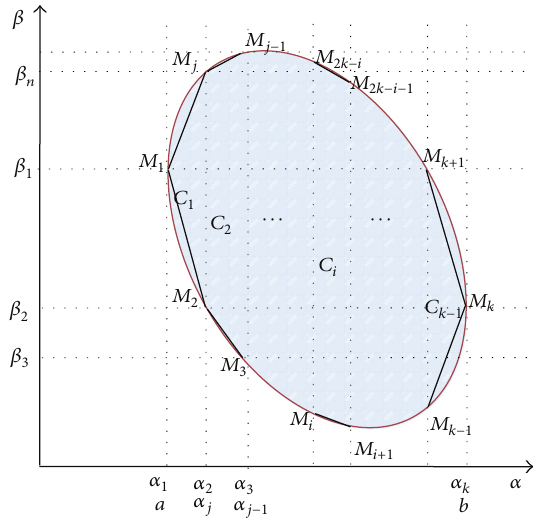
Figure 7: Task attitude constraints on plane.